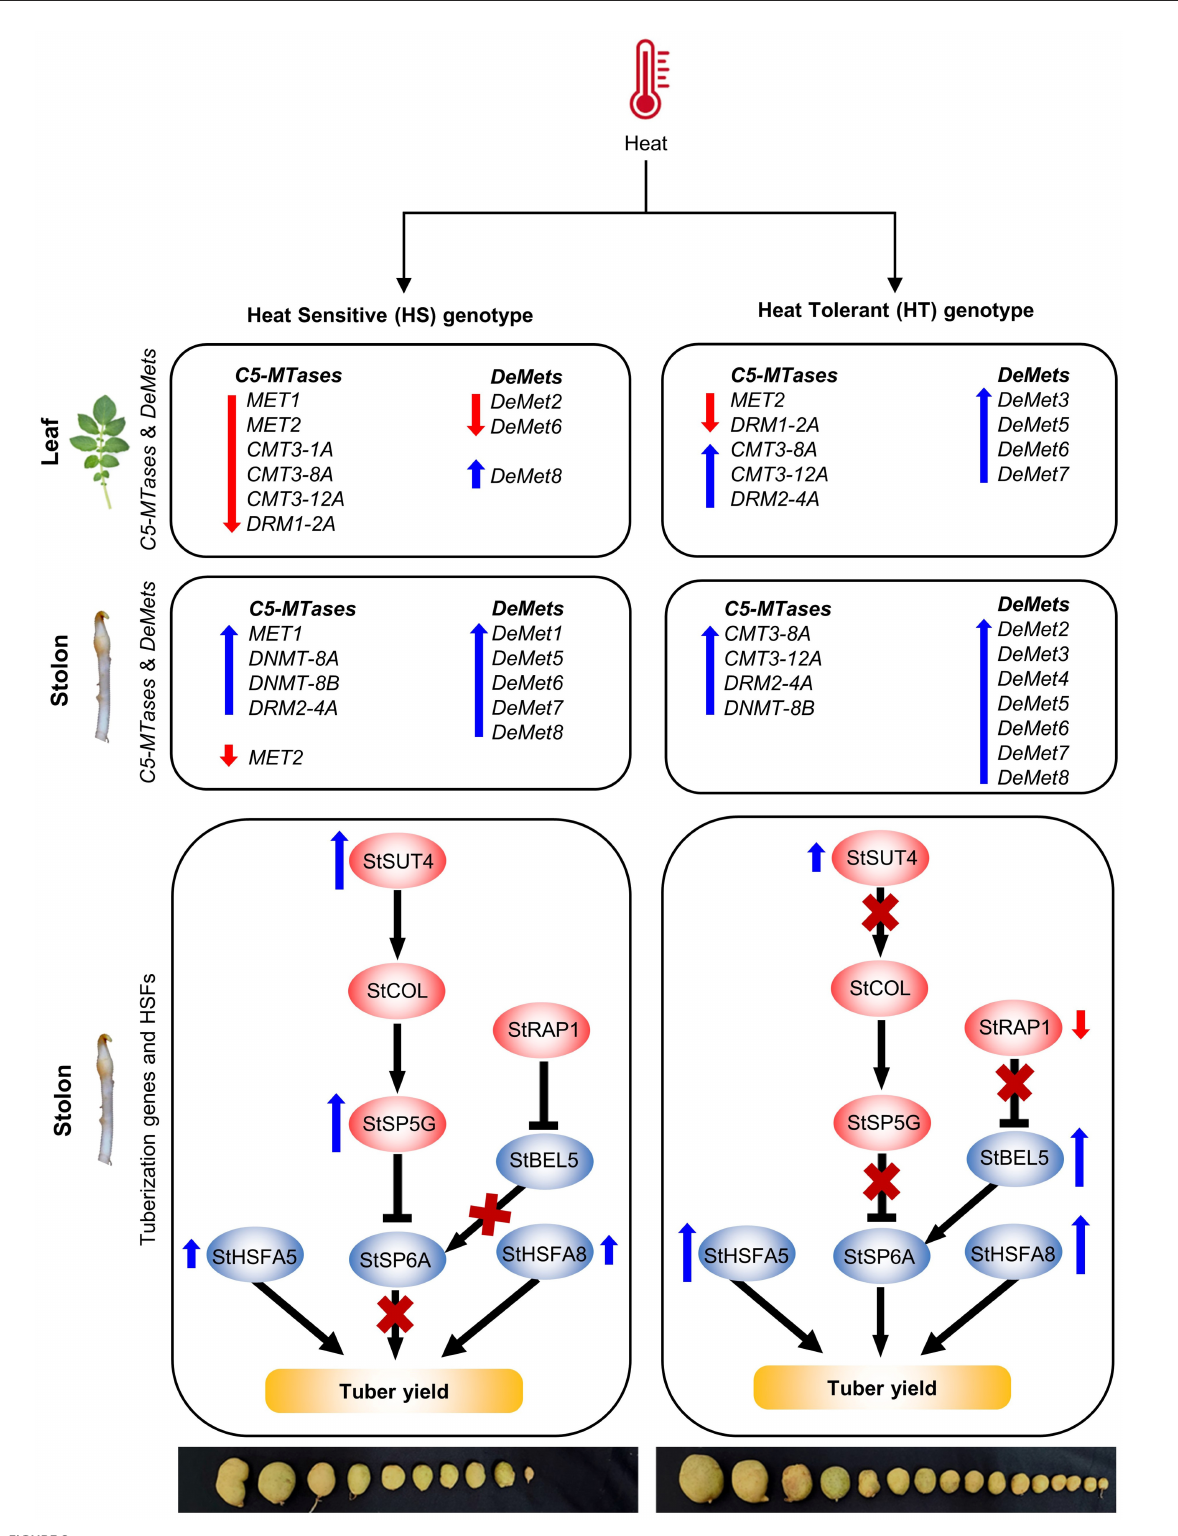
FIGURE8 The schematic model depicting the role of C5-MTase and DeMets gene with potato tuberization genes under high temperature in heat-tolerant (HT) and heat-sensitive (HS) genotype: Tuberization is regulated by positive ( StSP6A and StBEL5 ) and negative regulators ( StSUT4 , StSP5G , and StRAP1 ). Under high temperature, the positive regulators were relatively stable in the HT genotype as compared to the HS genotype. The